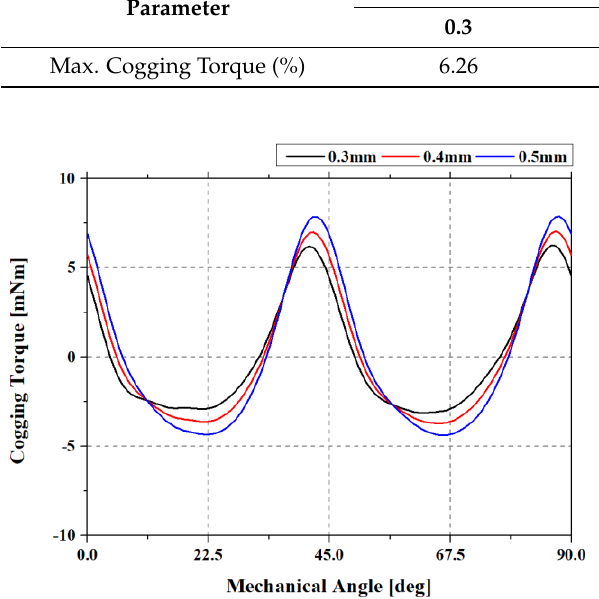
Figure 11. Waveform of the cogging torque for each design variable.